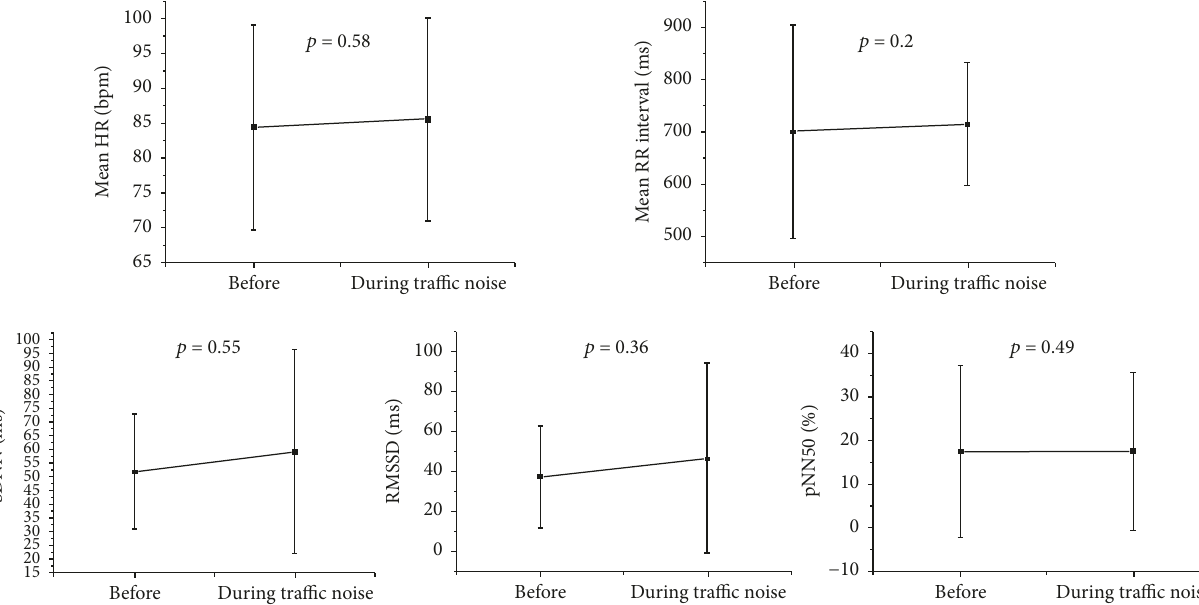
Figure 3: Mean heart rate and HRV analysis before (control) and during traffic noise exposure. pNN50: the percentage of adjacent RR intervals with a difference of duration greater than 50ms; RMSSD: root-mean square of differences between adjacent normal RR intervals in a time interval; SDNN: standard deviation of normal-to-normal RR intervals; HR: heart rate; 𝑝 : level of significance.